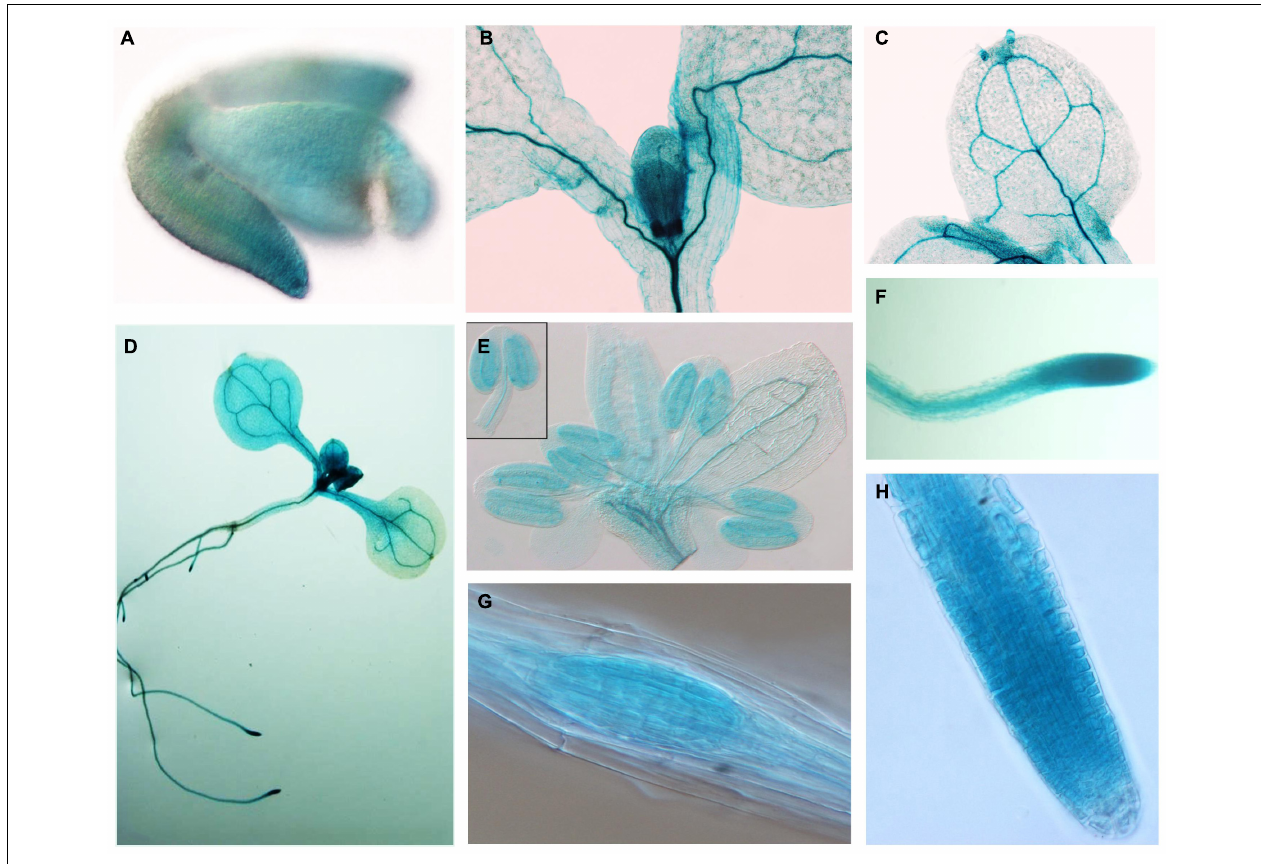
FIGURE 2 | APC11 tissue expression pattern. Expression of the p APC11 –GUS reporter gene at different developmental stages of two representative APC11 promoter lines. (A) Embryo showing early expression in the meristematic regions. (B) Shoot detail showing staining in the meristematic region. (C) Mature leaf showing a positive marker on vasculature system. (D) Seedling at 10 DAS. (E) Inflorescence at 30 DAS, detail showing the anther. (F) The Main root showing staining on the vasculature and meristematic region. (G) Secondary root meristem. (H) Main root tip at 6 DAS. Meristematic detail shows decreased expression on the elongated